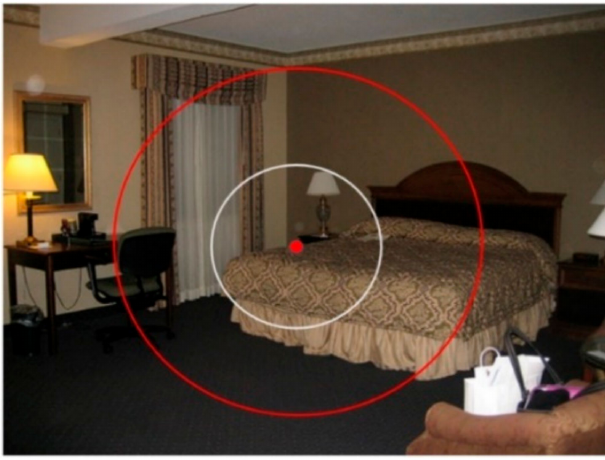
Figure 4. Illustration of anchor